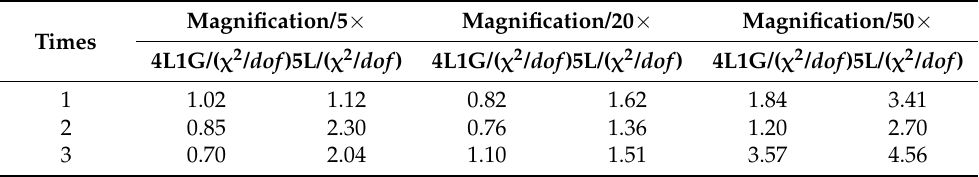
Figure 1. Raman original peak spectrum (objective lens magnification is 5 × ) five-peak fitting method; ( a ) 4L1G, ( b ) 5L. Table 2. Goodness of fit for the Raman spectra of sample with different peak combinations (4L1G and 5L) and indicated by χ 2 / dof value.